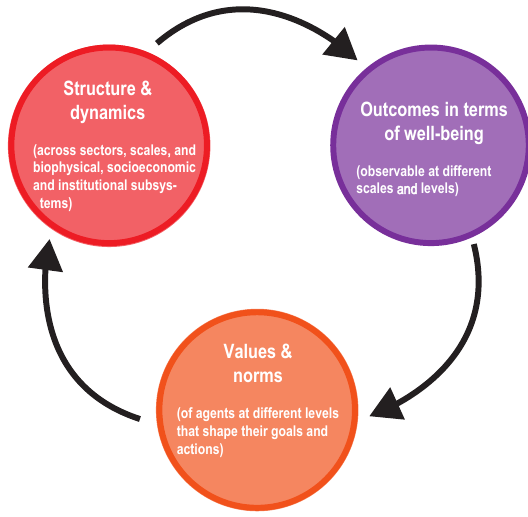
Figure 1. Framework proposed by Sivapalan et al. (2014). Socio- hydrology models use proxies for environment degradation and for economic